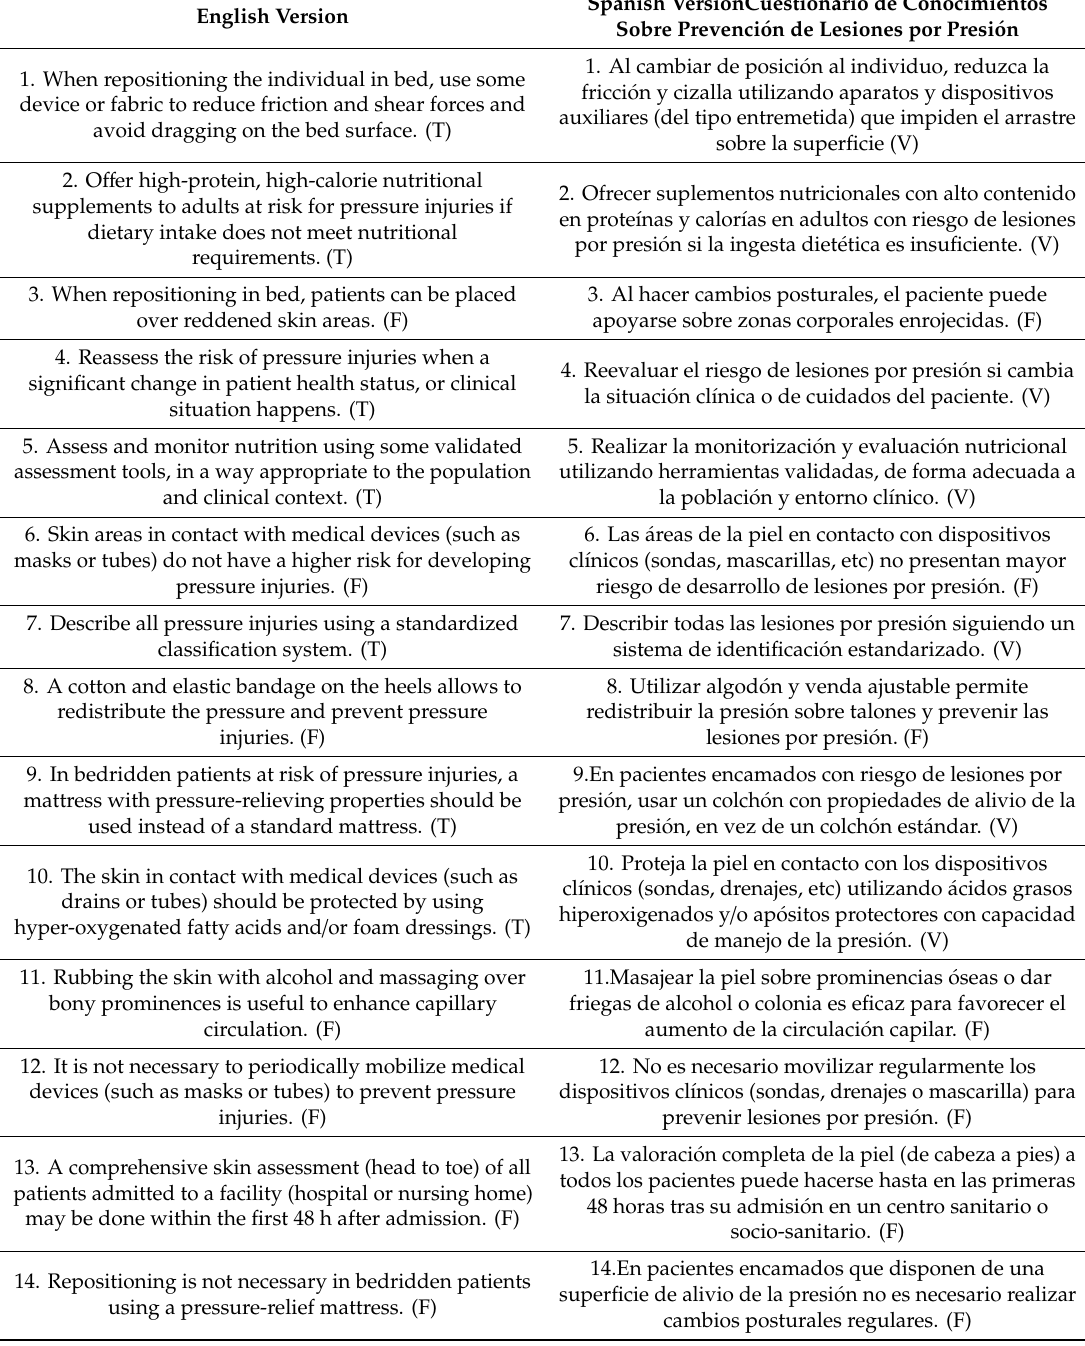
Table 6. The final version of Pressure Injury Prevention Knowledge (PIPK)